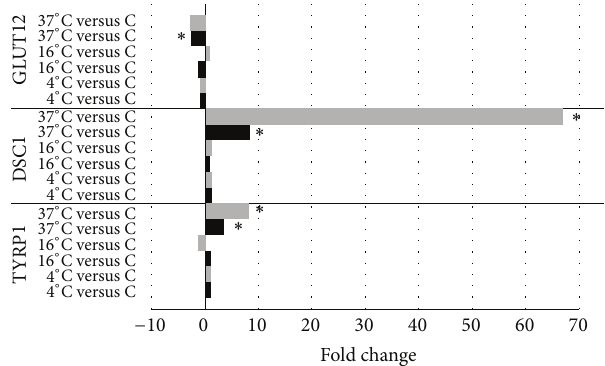
Figure 3: Validation of microarray expression results by qRT-PCR. Selected mRNAs (TYRP1, DSC1, and GLUT12) were differentially expressed in cultured RPE cells stored at different temperatures (4 ∘ C, 16 ∘ C, or 37 ∘ C) compared to control cells that had not been stored. Black bars indicate microarray expression values and grey bars represent PCR verification values. ∗ 𝑃 < 0.01